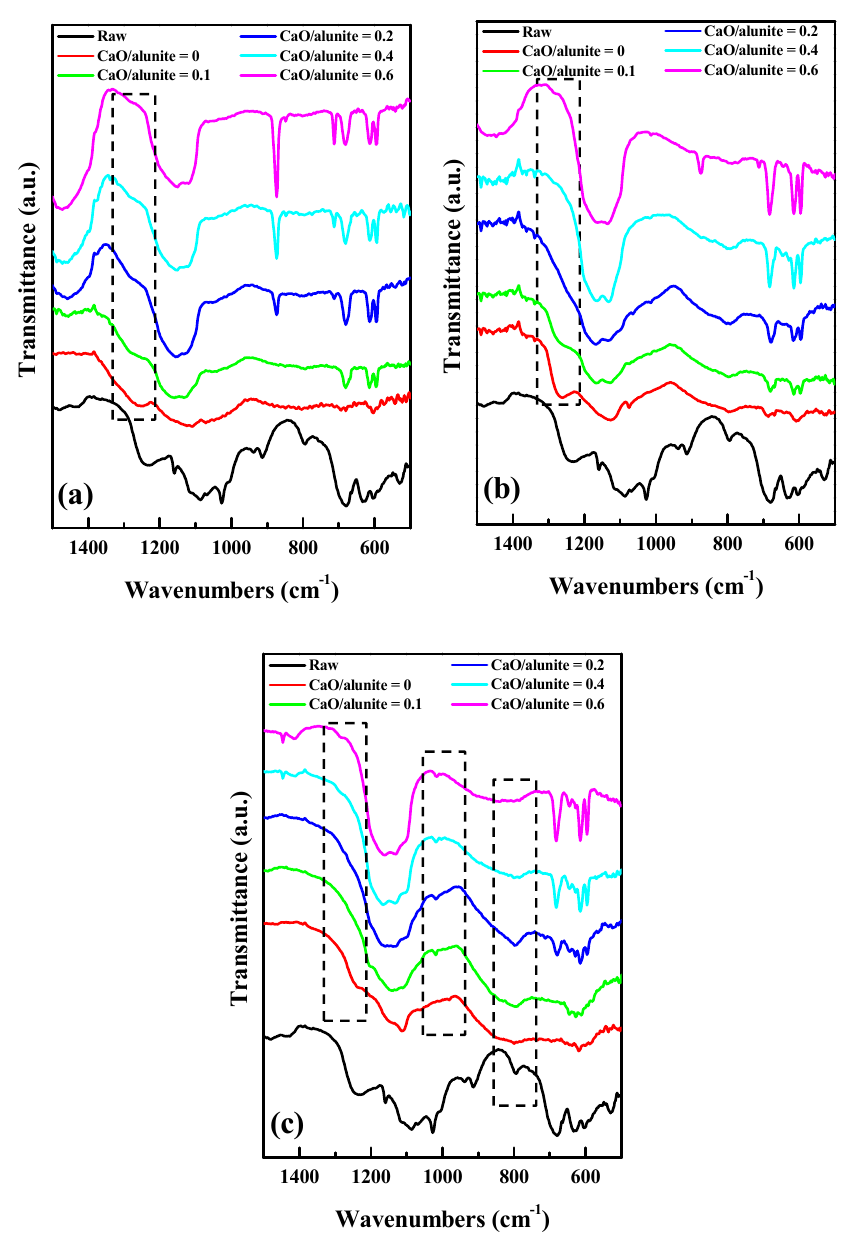
Figure 6. Fourier-transform infrared spectrometry (FTIR) absorption spectra of the alunite–CaO system (CaO/alunite = 0.4) at different decomposition temperatures: ( a ) 600 °C; ( b ) 700 °C; and ( c ) 800 °C.